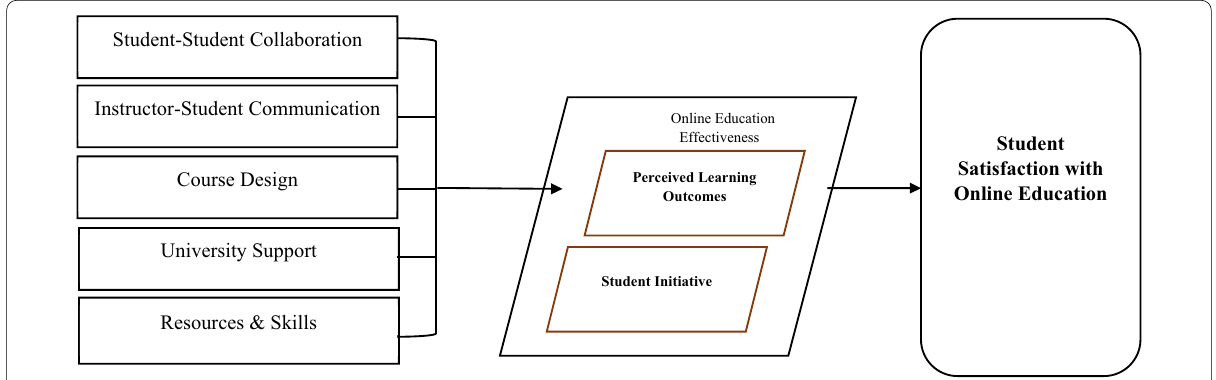
Fig. 2 Online education conceptual